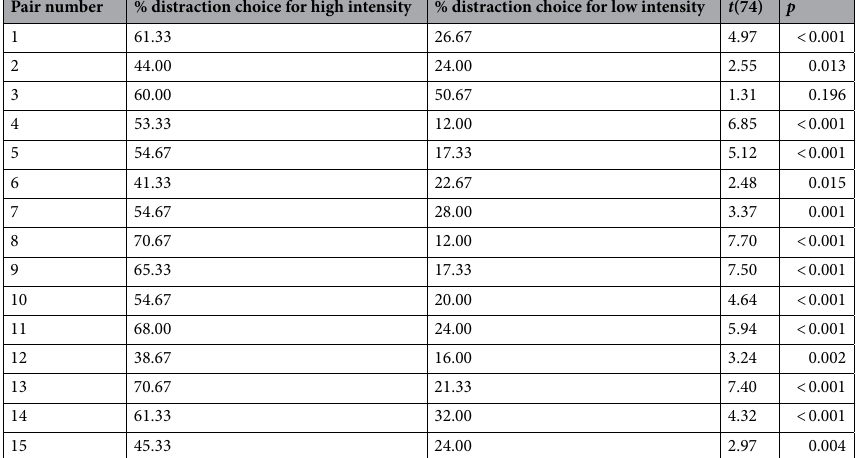
Pair number % distraction choice for high intensity % distraction choice for low intensity t (74)